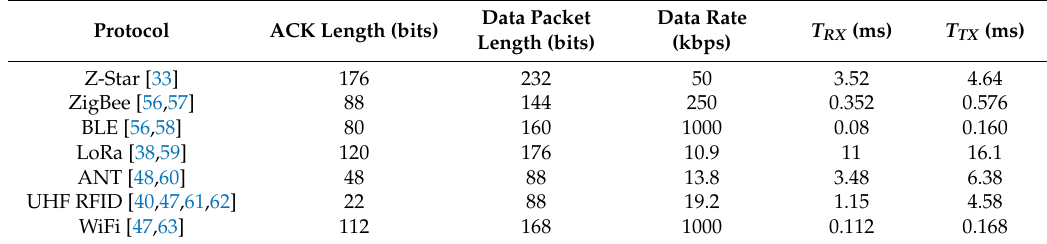
Table 4. Comparison of T TX and T RX as function of ACK Length, Data Packet Length and Data